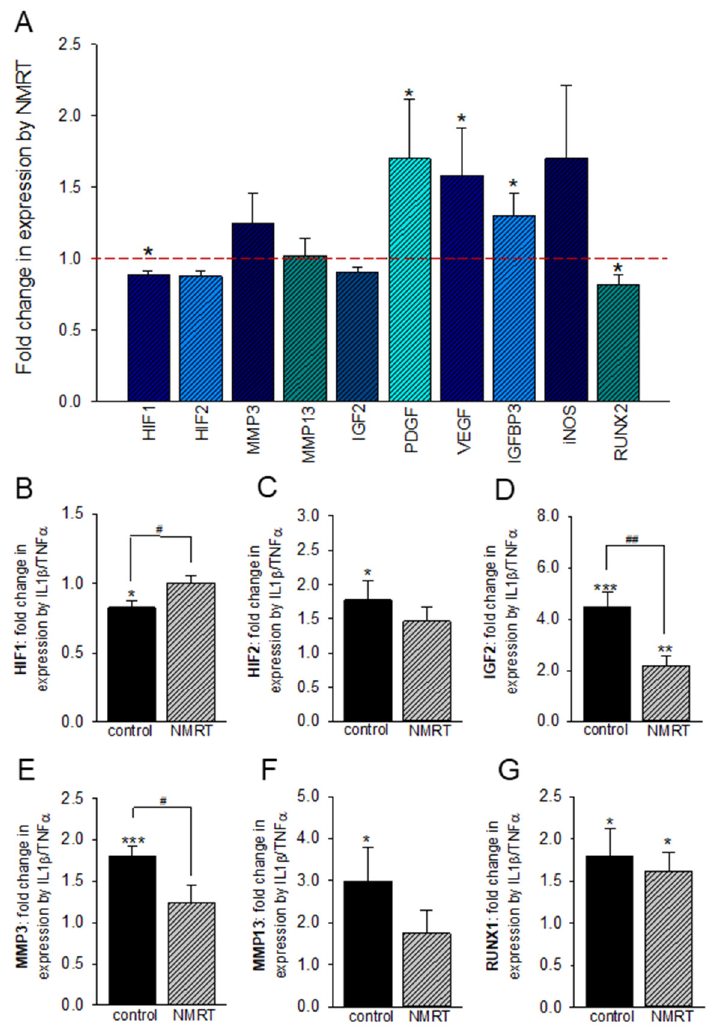
Figure 5. NMRT modulation in the expression of relevant genes in T/C-28a2 cells, the difference between untreated and treated cells is indicated; level of significance (*. p < 0.05, n = 4) Student’s t -test ( A ). Effects of IL-1 β /TNF α on the expression of HIF1, HIF2, IGF2, MMP3, MMP13, and RUNX1 are given as change in expression ratio (2 −∆∆ Ct ) ( B – G ); significant changes are depicted (*) and were calculated via the Student’s t -test (*: p < 0.05; **: p < 0.01 and ***: p < 0.001). For HIF1, IGF2, and MMP3 the significance of the IL-1 β /TNF α ratio between control and NMRT treatment is outlined by hash tags (#: p < 0.05, ##: p < 0.01).